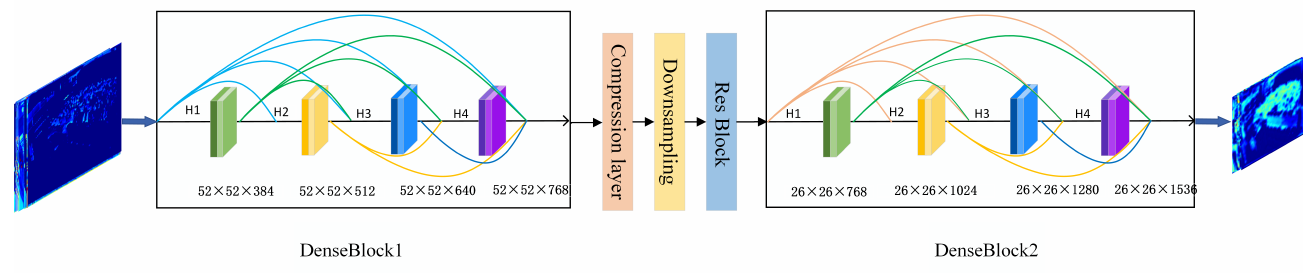
Figure 2. The internal parameters and structure of